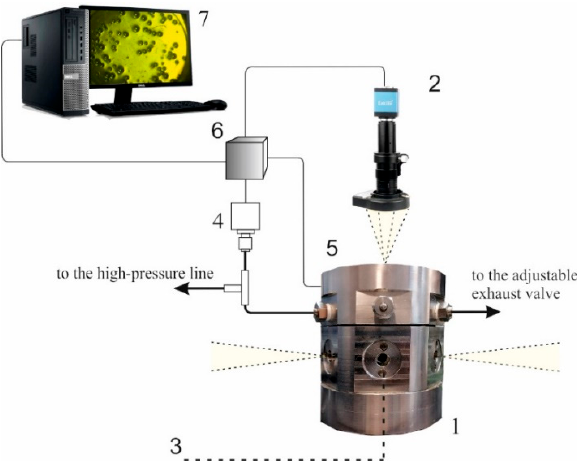
Figure 2. Experimental equipment for the analysis of bubbling in carbon dioxide-plasticized D , L - polylactide. 1—multi-window high-pressure chamber; 2—CMOS camera with the macro-lens and illumination assembly; 3—sapphire glass window (one of seven); 4—pressure gauge; 5—output of the thermocouple; 6—data acquisition assembly; 7—PC. Resistance-type heaters are not shown. Yellow-filled sectors display the side-window and upper-window illumination. The chamber is connected with the CO 2 -filled controllable high-pressure line via a shutoff valve (not shown).